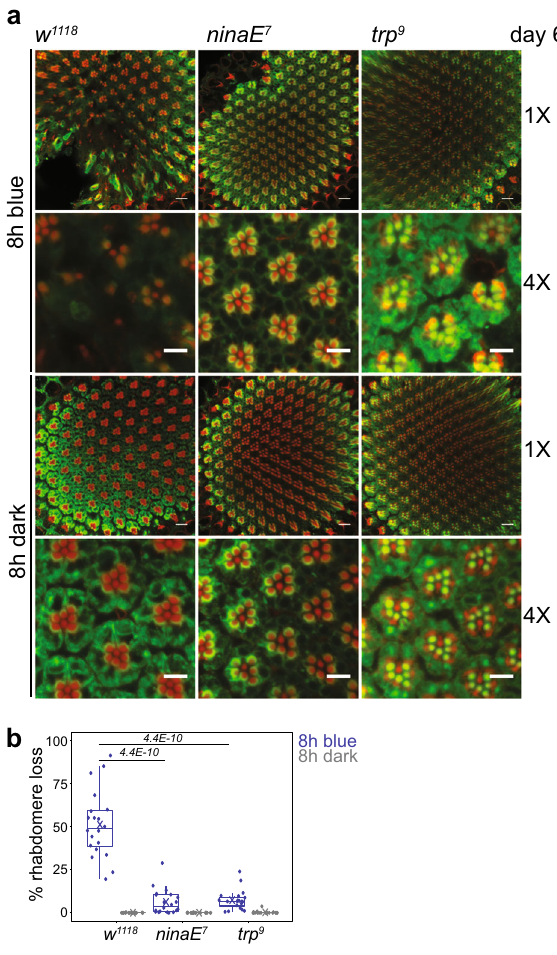
Fig. 2 Blue light-induced retinal degeneration requires an intact phototransduction pathway and Ca 2+ in fl ux. a Confocal images of adult retinas from w 1118 , ninaE 7 and trp 9 fl ies exposed to 8 h blue light or dark control at 6 days post-eclosion. Flies were maintained in the dark prior to blue light exposure to prevent light-induced degeneration in the mutant backgrounds. b Box plots showing rhabdomere loss quanti fi ed using the confocal images. FDR, pairwise Wilcoxon Rank Sum Test between wild type ( w 1118 ) and mutant genotypes under blue light treatment ( n = 4 light treat- ments; 5 animals/experiment) shown to protect the mouse retina from light-induced damage. 26 However, overexpression of Cyt-b5 did not alter the ratio of polyunsaturated fatty acids, or increase relative levels of palmitoleic acid, in the eye (Supplementary Fig. 3). Thus, Cyt-b5 is unlikely to suppress blue light stress-induced retinal degenera- tion via altering polyunsaturated fatty acid levels. Therefore, we sought to identify alternative mechanisms through which Cyt-b5 could suppress blue light-induced retinal degeneration. Cyt-b5 is the rate-limiting electron-donor for the NADH-dependent reduc- tion of membrane resident antioxidant coenzyme Q, which quenches lipid peroxidation and protects cells from oxidative stress. 27,28 Because their photosensory membranes are rich in susceptible polyunsaturated fatty acids, photoreceptors are at special risk for damage by lipid peroxidation, a ROS-induced peroxyl radical chain reaction that propagates across cell membranes, compromising membrane organization and cellular integrity. We hypothesized that Cyt-b5 overexpression promotes coupling of Cyt-b5 and its reductase, enhancing plasma mem- brane antioxidant defenses. Based on this hypothesis, we